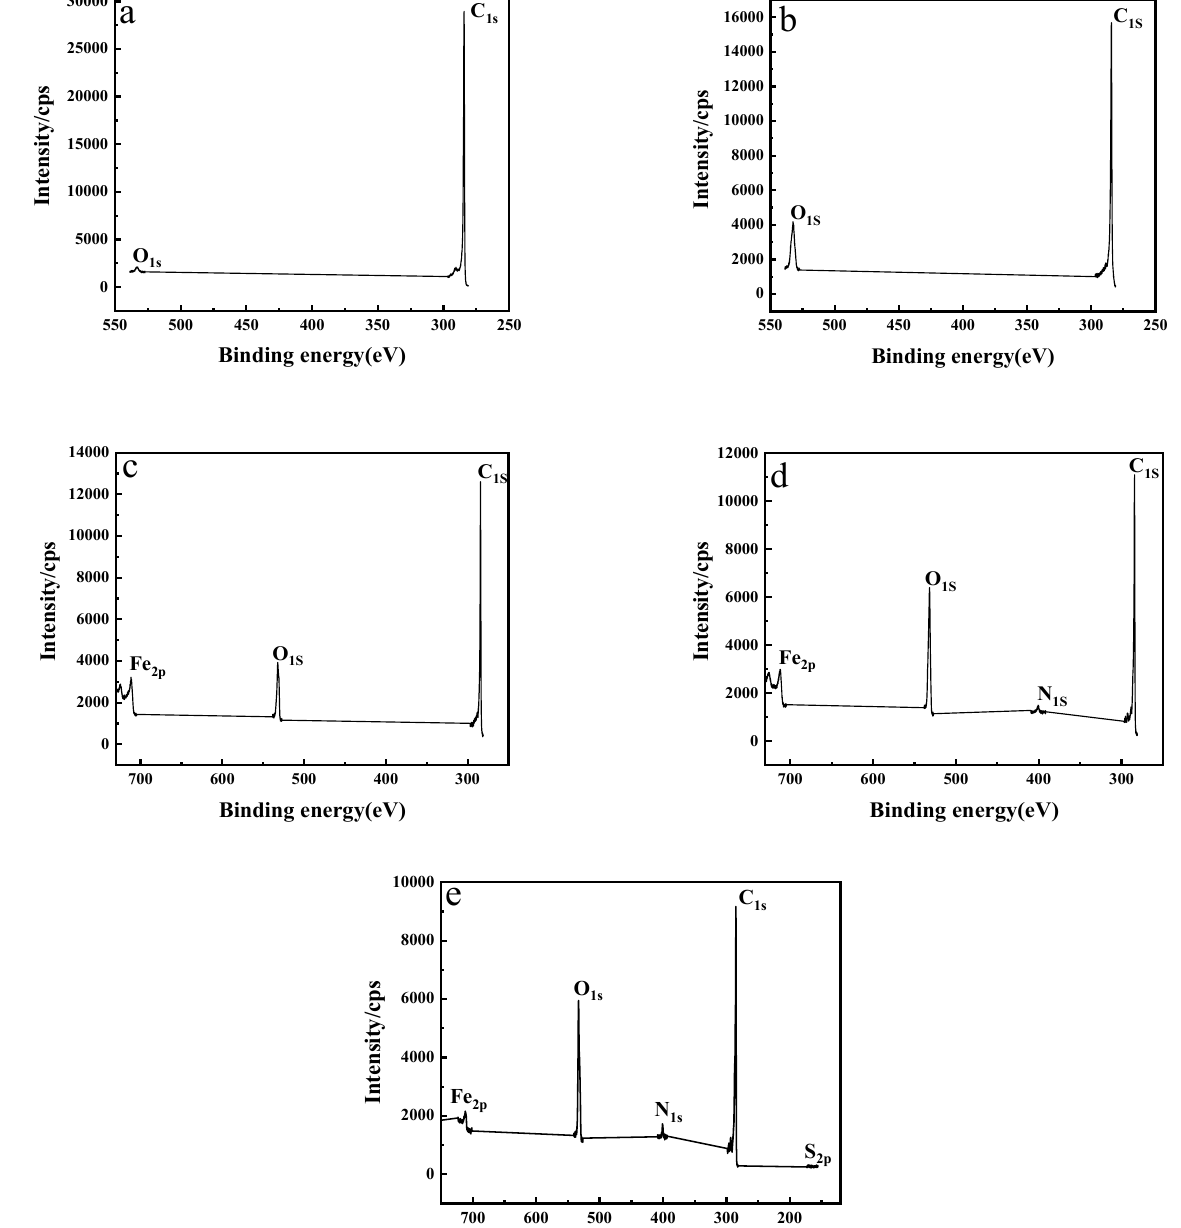
Figure 1. XPS spectra of ( a ) crude MWCNTs; ( b ) MWCNTs-COOH; ( c ) mMWCNTs; ( d ) mMWCNTs@4-armPEG-NH 2 ; ( e ) co-immobilized ROL and CRL-mMWCNTs@4-armPEG-NH 2 .